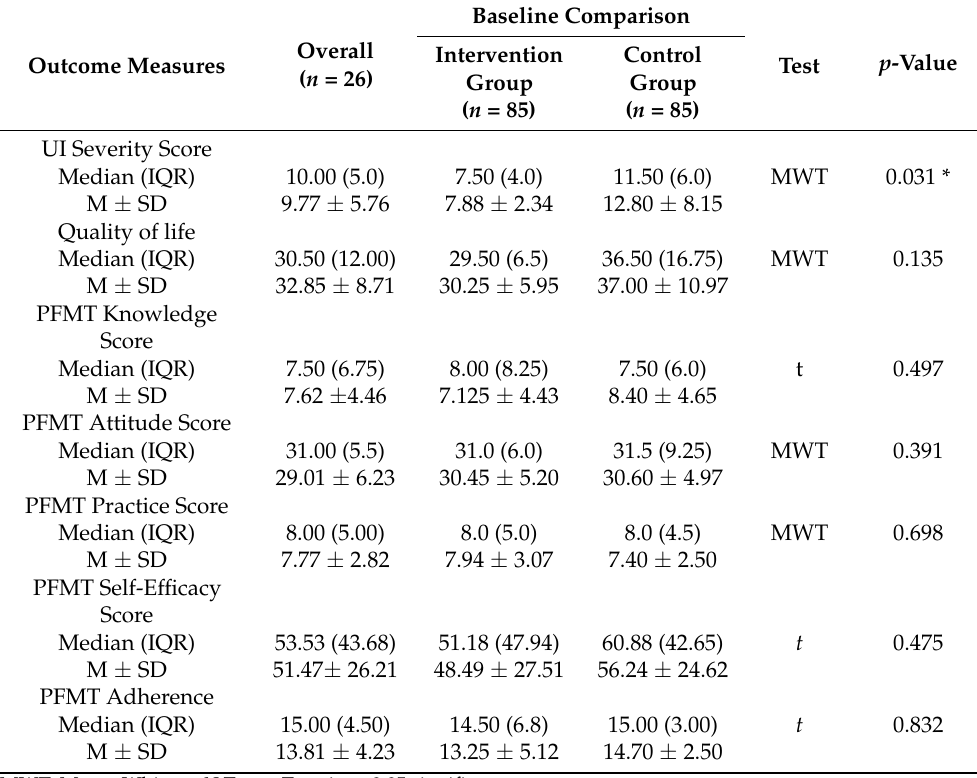
Table 4. Baseline outcome measures and comparison between intervention and control groups.